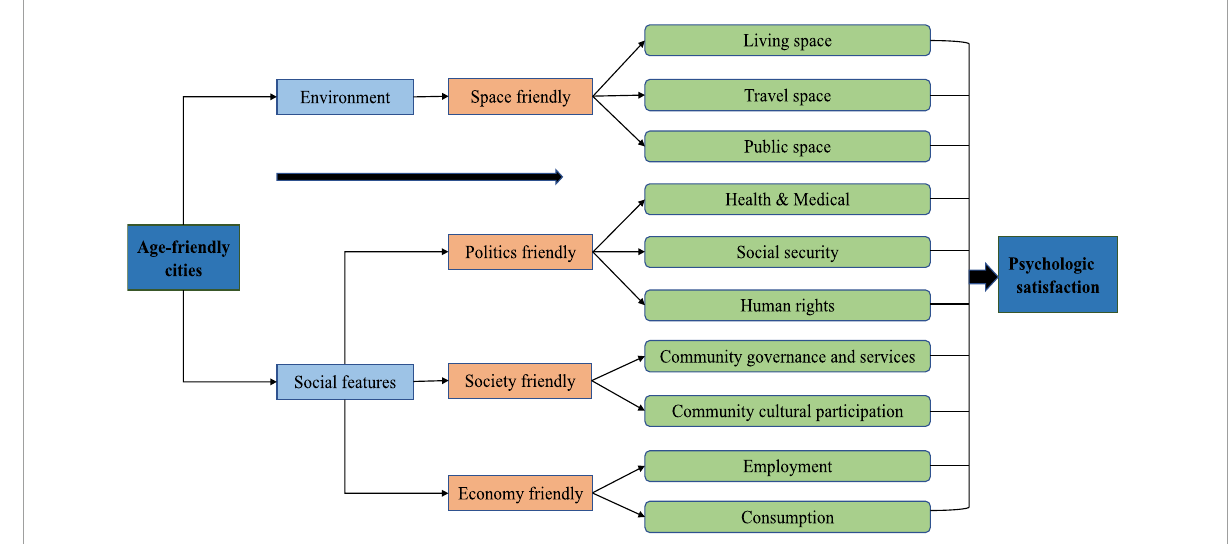
FIGURE1 How do age-friendly cities lead to psychological satisfaction? (Source: Authors).